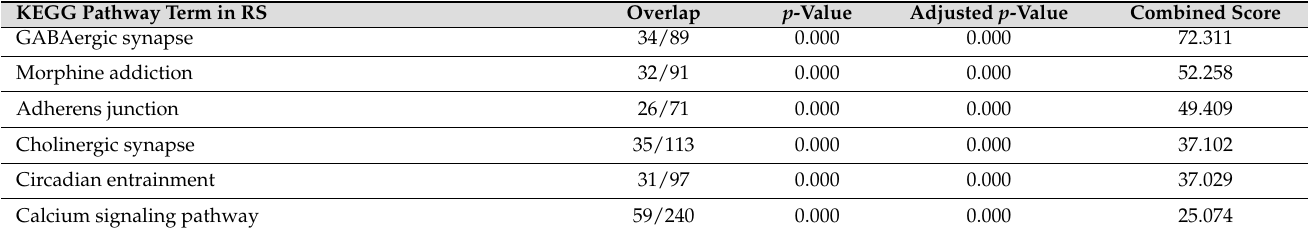
Table 7. Results of pathway enrichment analysis for genes that were found common for replicative senescence (RS) in human DSF, hBM-MSC and hAd-MSC. Only terms for which adjusted p -value reached the statistical significance level of 0.05 are listed. For the description of column names,